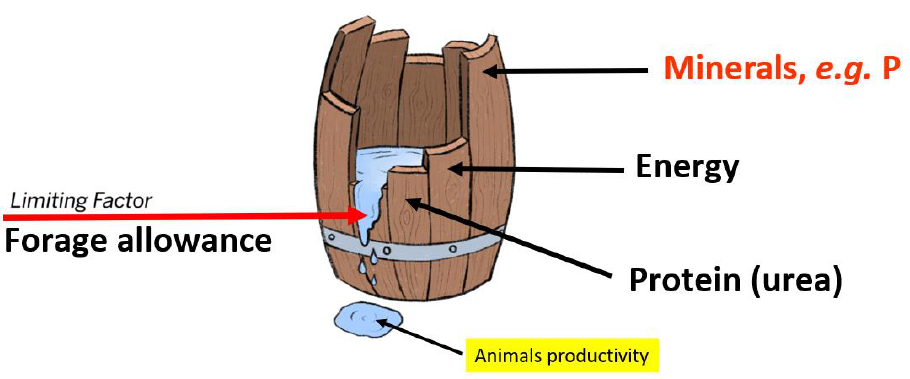
Figure 16. The law of the minimum applied to a ruminant production system in the dry season, in which the limiting variable (lowest stave of the barrel) is the forage mass on offer.